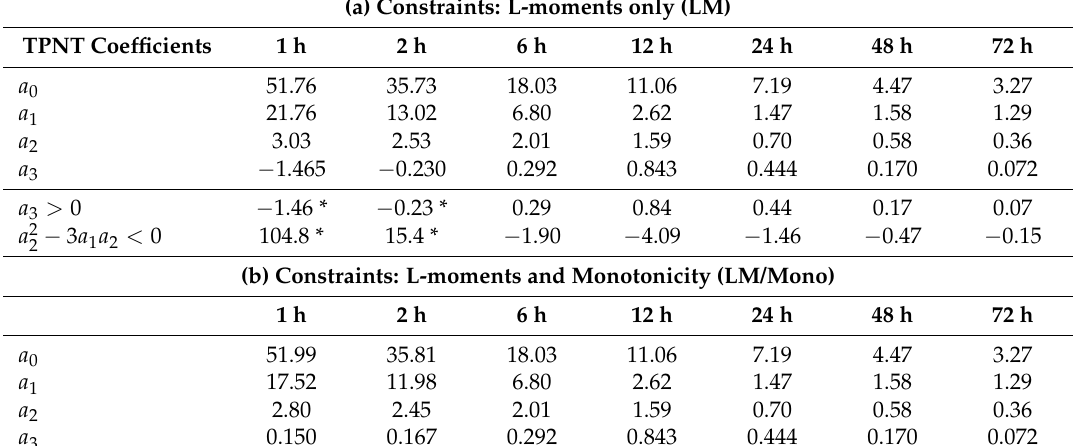
Table 6. Multivariate TPNT coefficients obtained under different constraints with α = 0.90. (a) Constraints: L-moments only